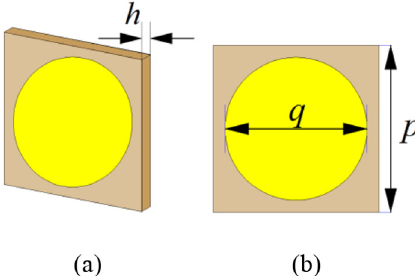
Fig. 1. The schematic of the unit cell of the proposed PMA. (a) Perspective view; (b) front view.